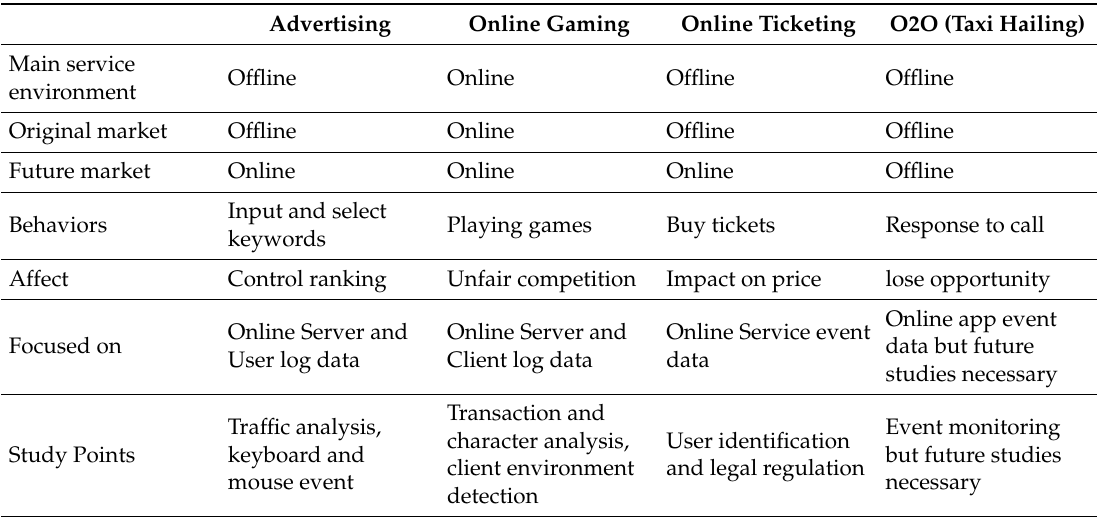
Table 1. The summary of comparison in Advertising, Online Gaming, and Online Ticketing. Advertising Online Gaming Online